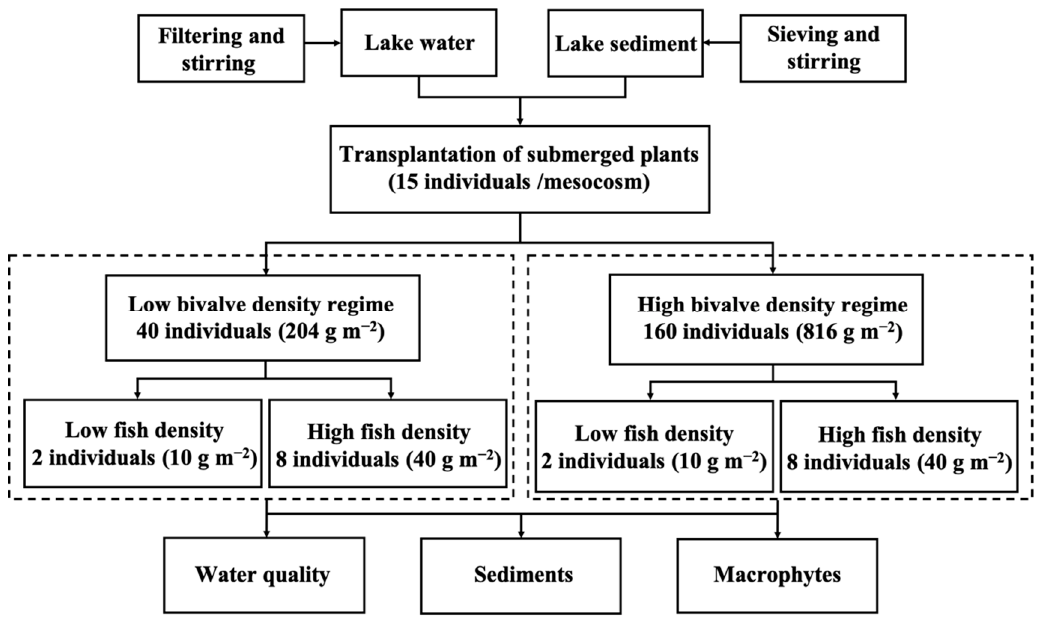
Figure 2. The experimental design and scheme.